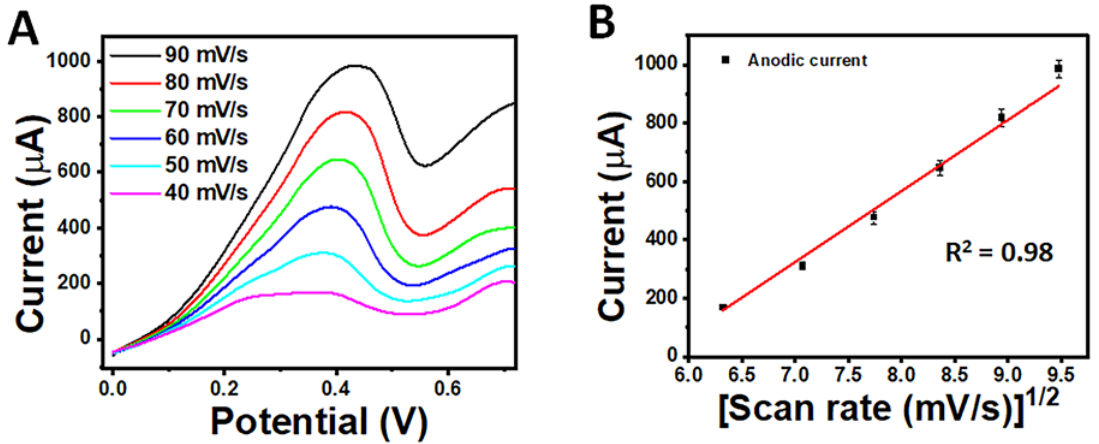
Figure 6. ( A ) LSV current signals of GCE (light blue curve), GCE/Co (grey curve), GCE/Cu (red curve), GCE/Au (green curve), and GCE/AuCoCu electrodes (blue curve) matrices in ZS (5 mM; pH- 7, scan rate-100 mV/s); ( B ) Peak currents of electrode surfaces displayed in a comparative histogram; ( C ) EIS responses of GCE (light blue curve), GCE/Co (grey curve), GCE/Cu (red curve), GCE/Au (green curve), and GCE/AuCoCu electrode (blue curve) matrices with their circuit models; ( D ) Com- parative histogram illustrating the corresponding Rct values.